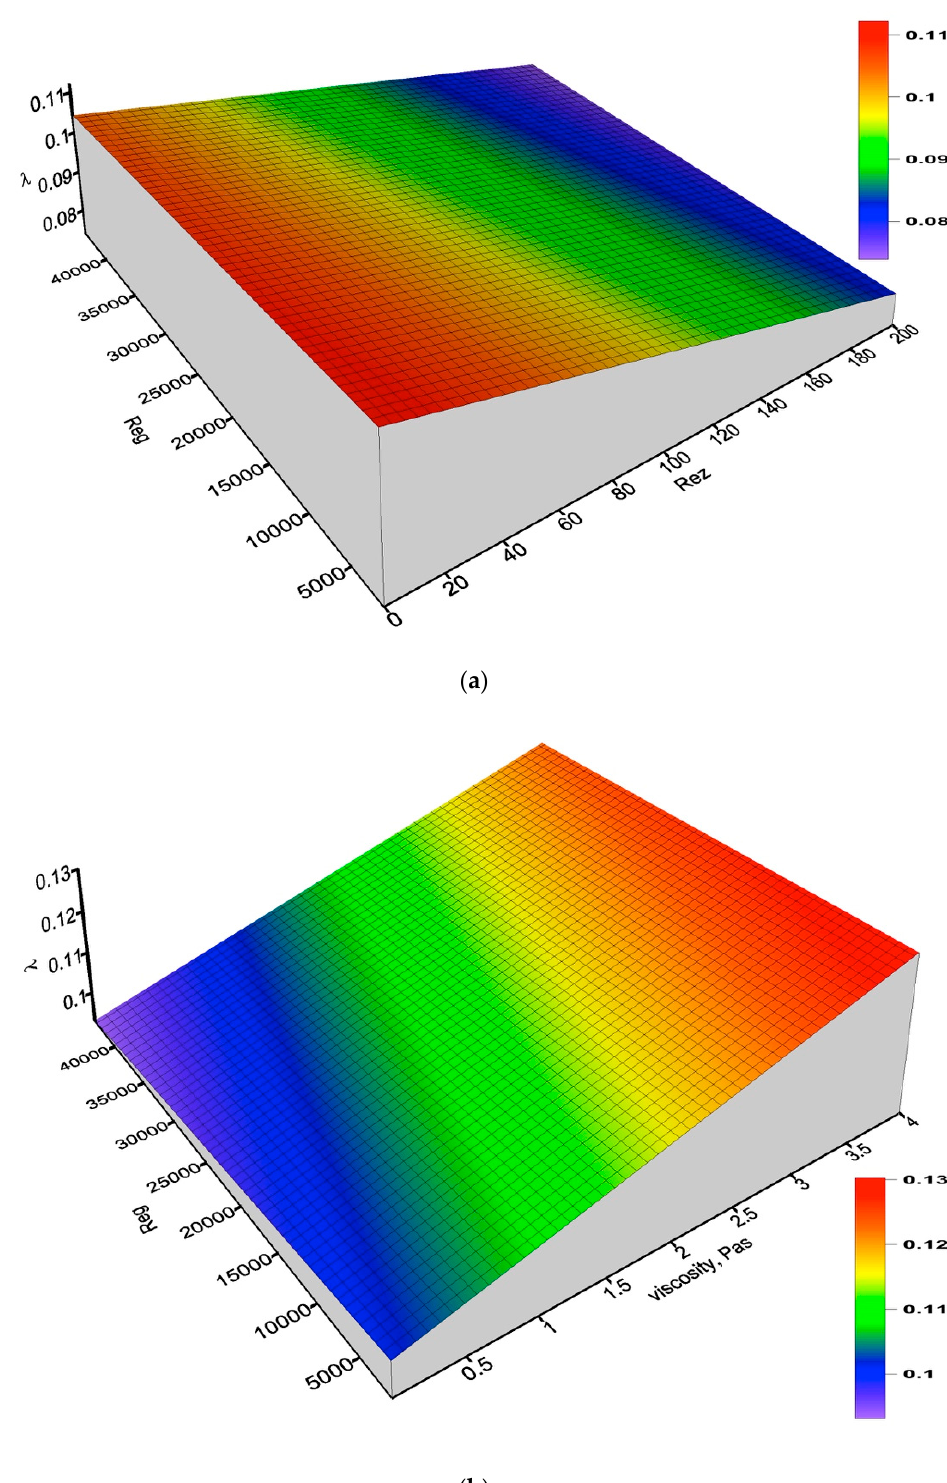
Figure 16. Results of calculations of wavelength accompanying two-phase gas-very viscous liquid flow for relation (16). (a) depending on Re z value; (b) depending on the viscosity value.